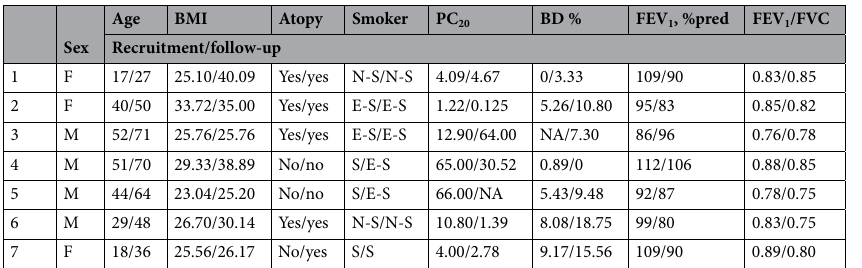
Table 2. Changes in the respiratory status of seven participants who developed asthma between recruitment and follow-up evaluation. BMI body mass index (kg/m 2 ), BD bronchodilator response, E-S ex-smoker, FEV